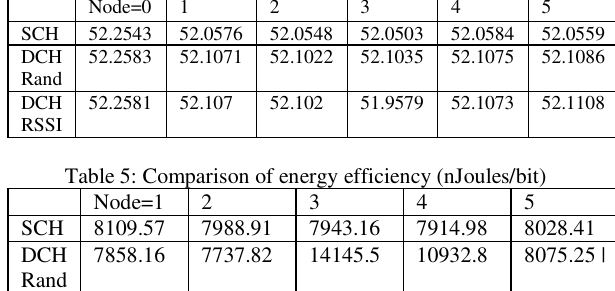
Table 4: Comparison of total consumed energy (Joules) Node=0 1